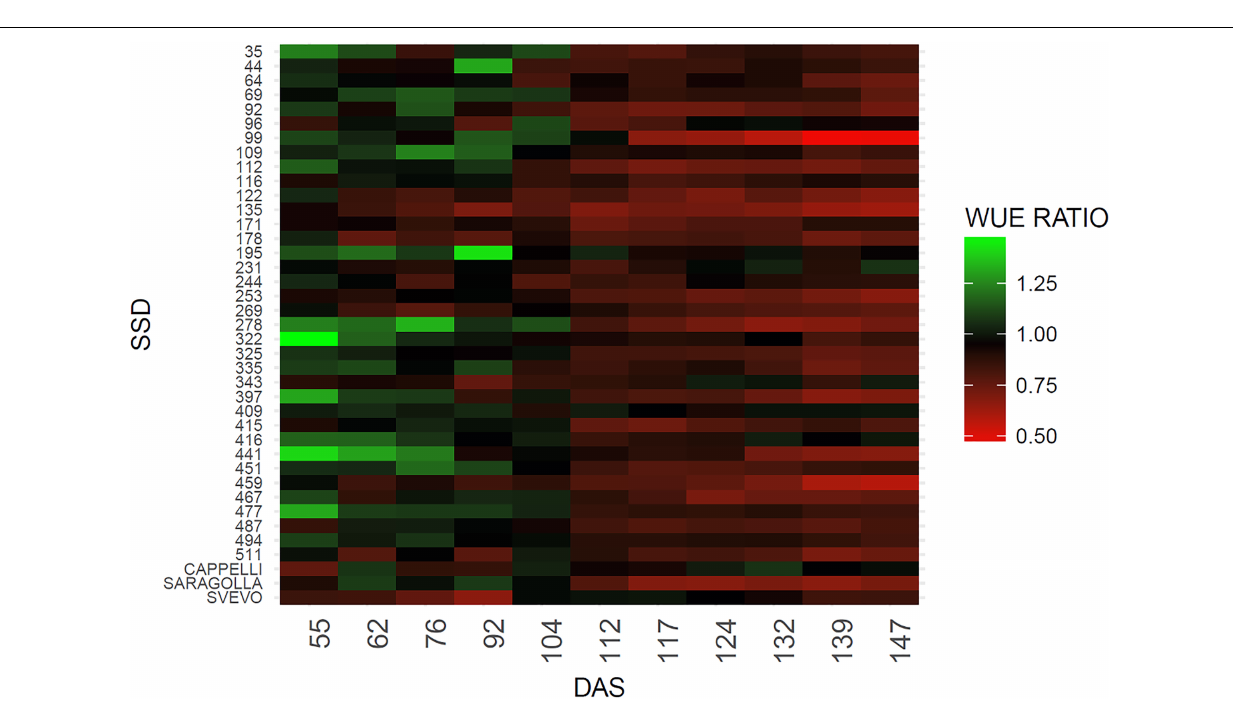
FIGURE 4 | Heatmap of WUE ratio for the analyzed genotypes. The green color indicates a higher WUE ratio, red color a lower WUE ratio. WUE ratio is calculated as WUE of drought stresses plants/WUE control